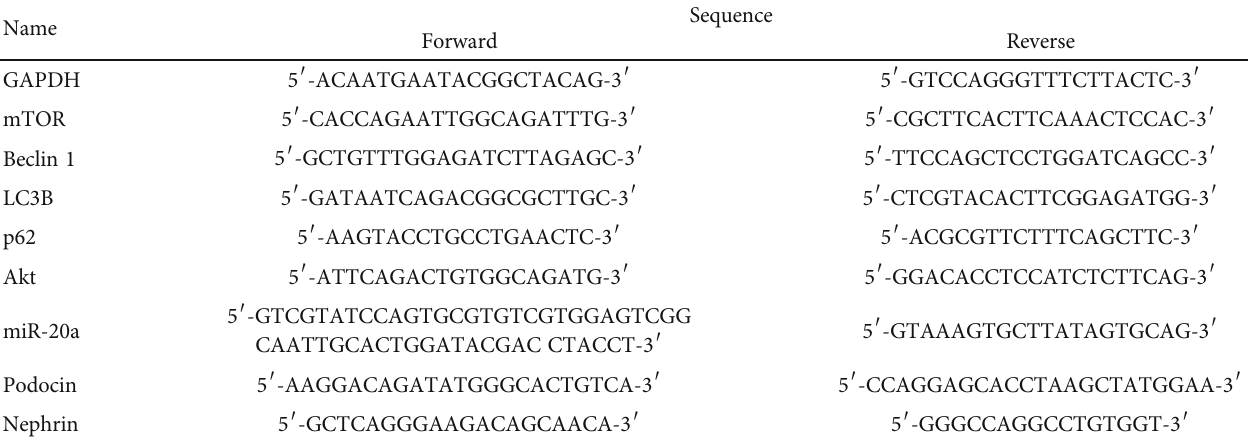
Table 1: Sequences of